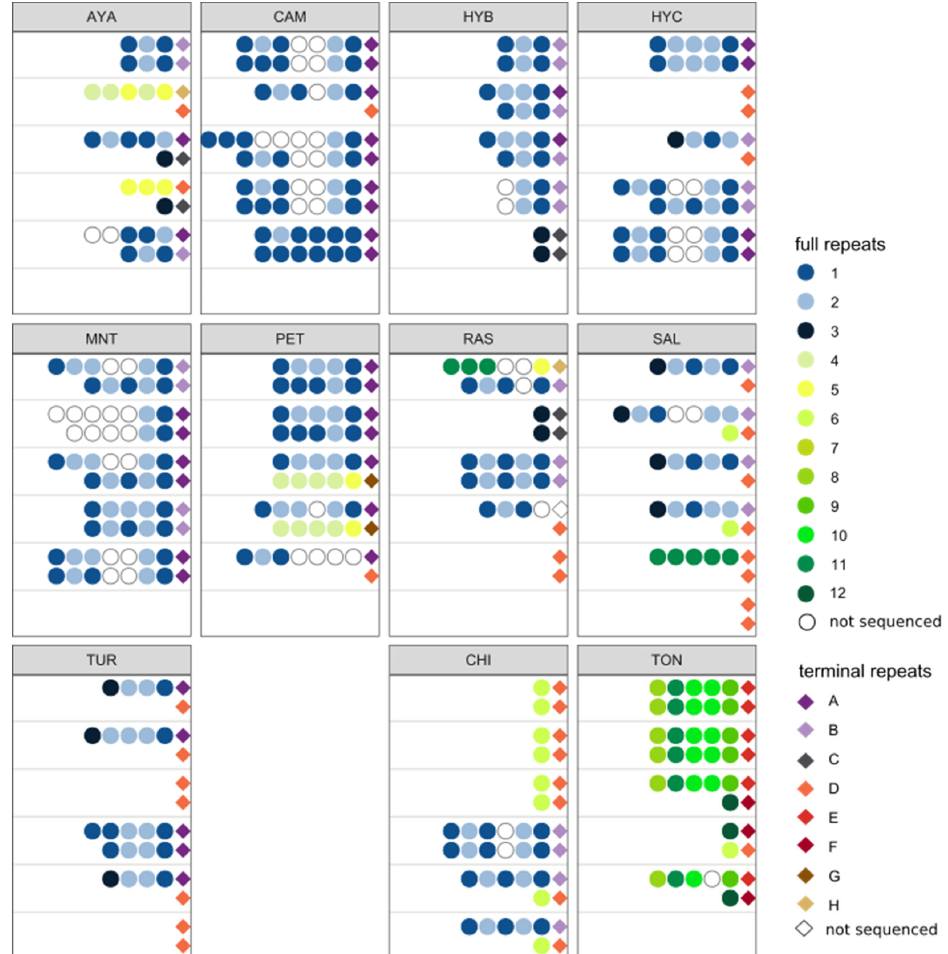
Figure 2. mmr ‐ b alleles found in the isolates. Each vertical box represents a population, and each pair of rows with symbols are the two mmr ‐ b of a single clone. Each colour represents a different haplotype, either from full repeat (circle) or terminal repeat (diamond). The two detached boxes (CHI and TON) are the outgroup populations.